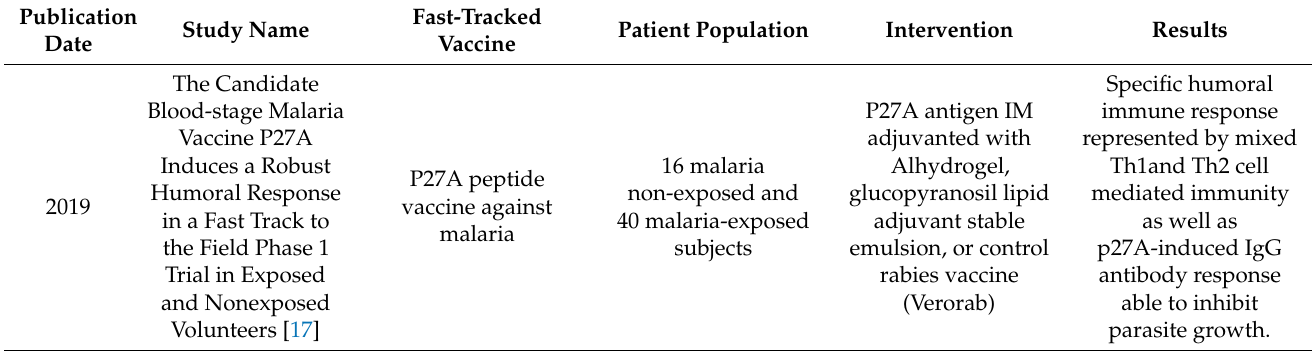
Table 2. Parameters and results of the studies reviewed for